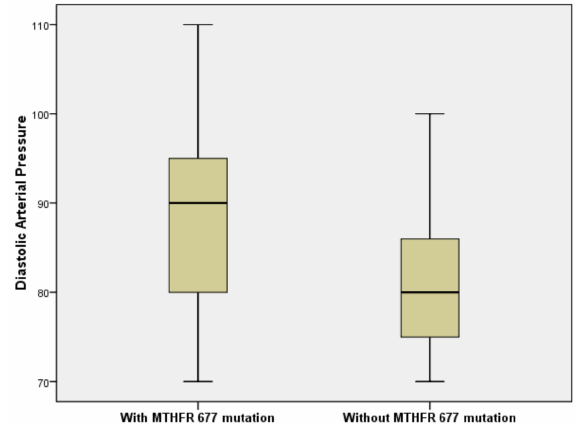
Figure 1. Patients with C677T mutation have a higher risk for developing higher DBP values (odds ratio (OR) = 1.881, 95%CI = (1.804, 4.964)).